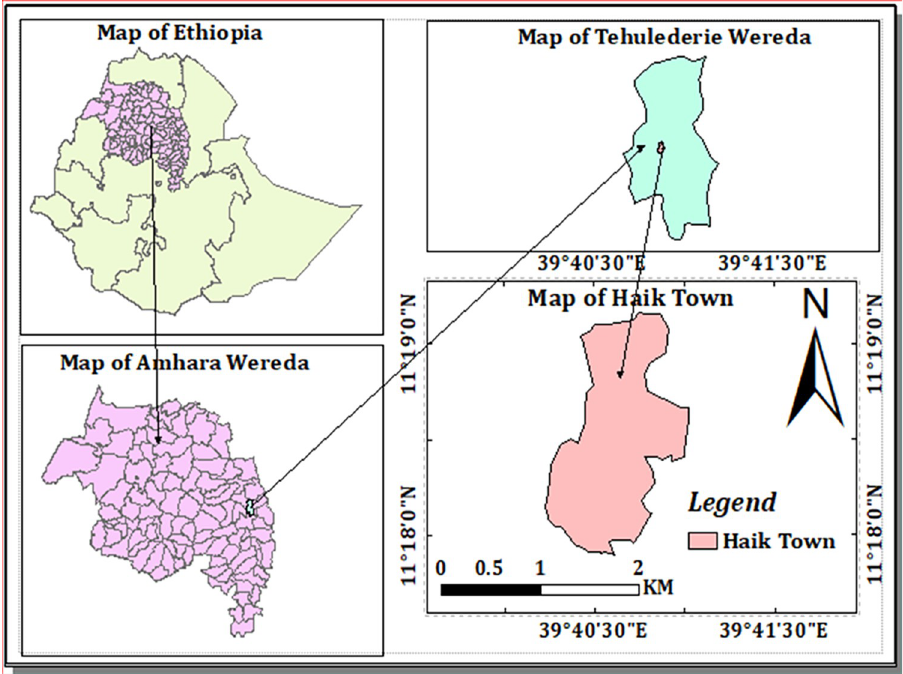
Fig 1. Map of the study area. The above maps were generated by ourselves using the ArcGIS version 10.8 software. The shape files of Ethiopia administrative regions, zones, woredas and towns were freely downloaded from a link https://africaopendata.org/dataset/ethiopia-shapefiles.